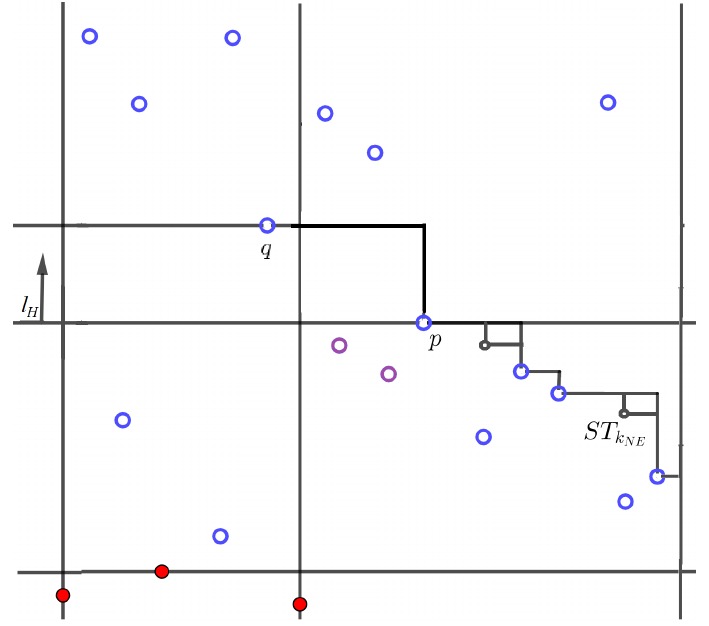
Figure 6. Case 3. p ∈ B NE , q ∈ B N . The purple empty dots denote U ( p )